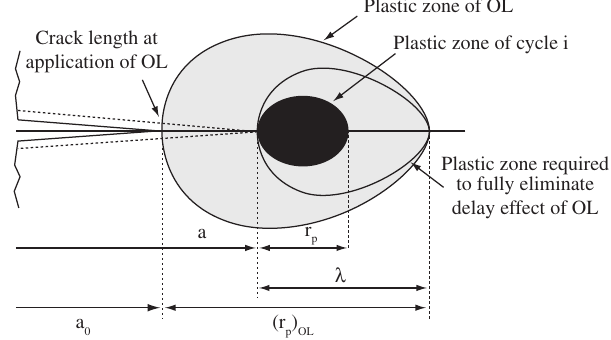
Figure 1. Plastic zone size definitions used in the model of Wheeler, cor- responding to a generic cycle i 20